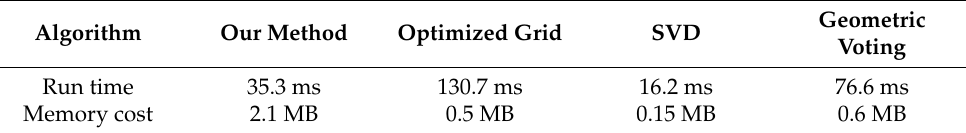
Figure 8. Identification rate versus false stars. Table 4. Time and Memory